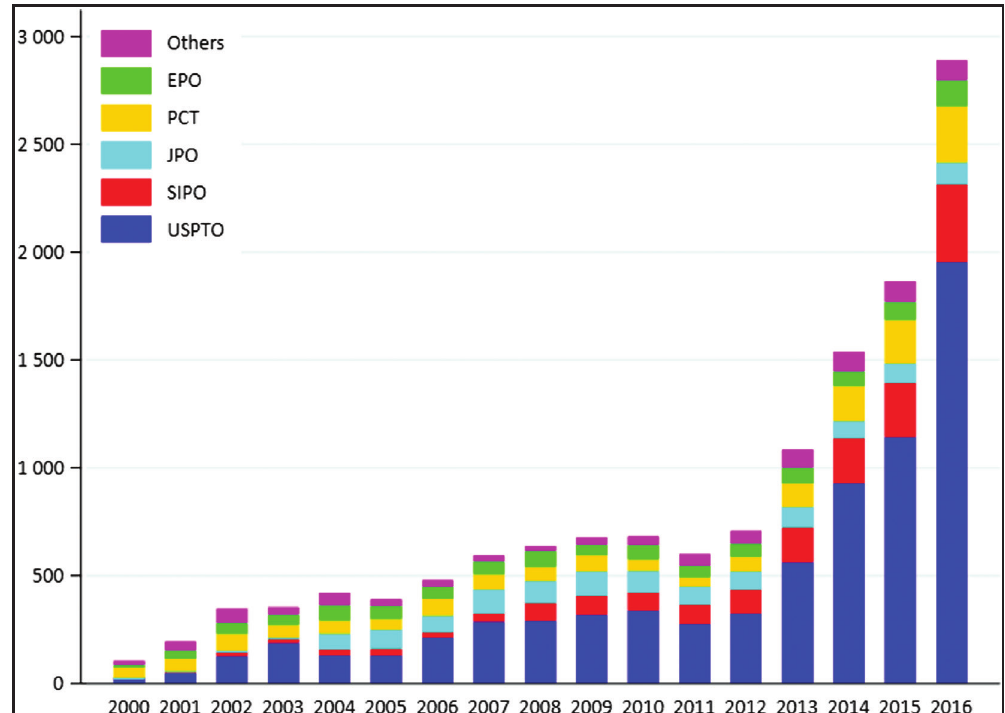
Figure 1 Number of AI patents granted by